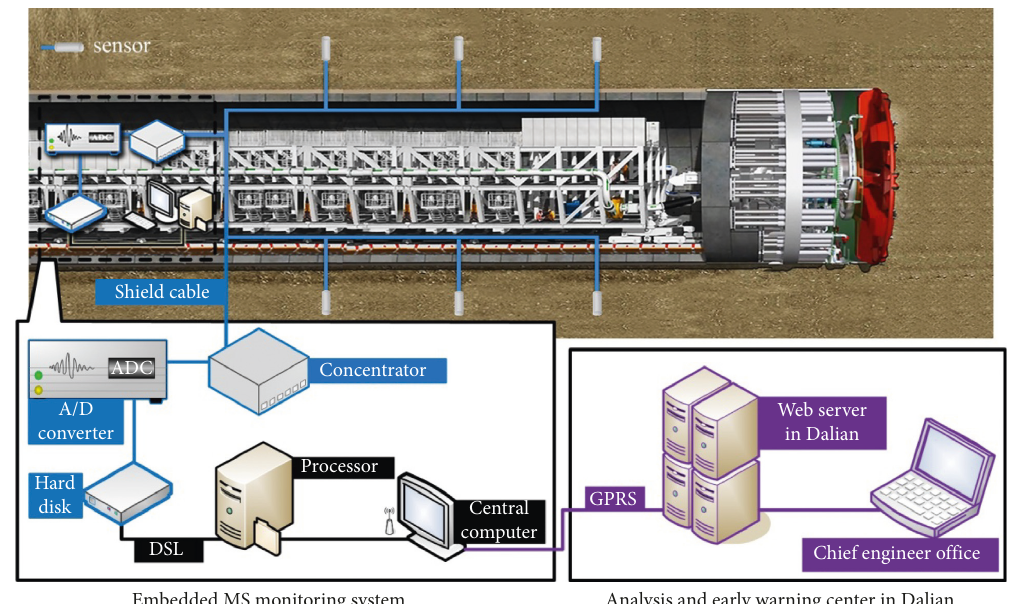
Figure 9: Topological graph of a movable integrated system for MS monitoring and early warning of rockbursts during TBM tunneling.